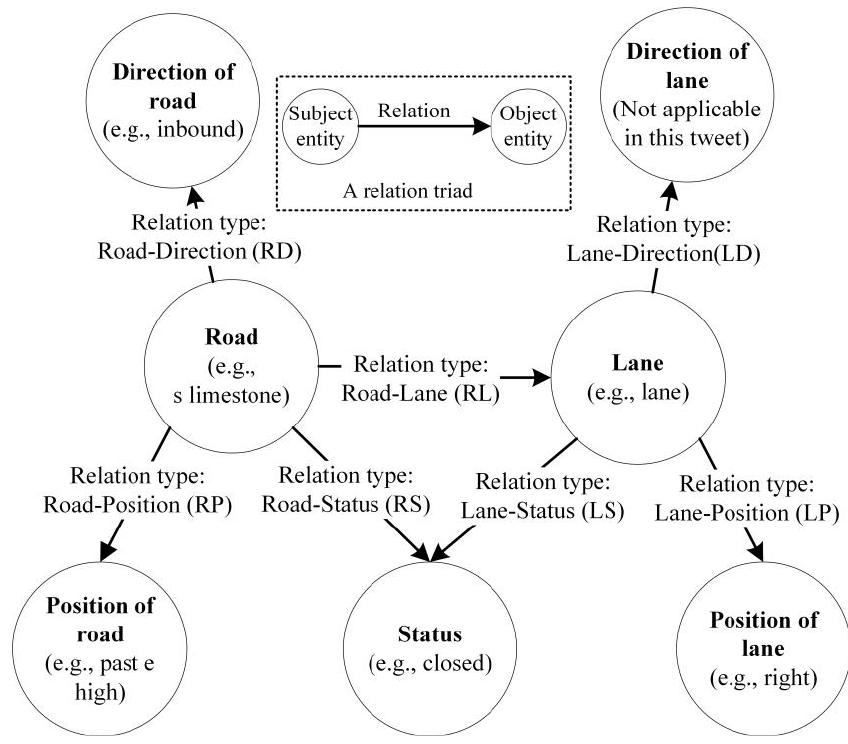
Figure 2. Annotation schema of desired information extracted from social media data.